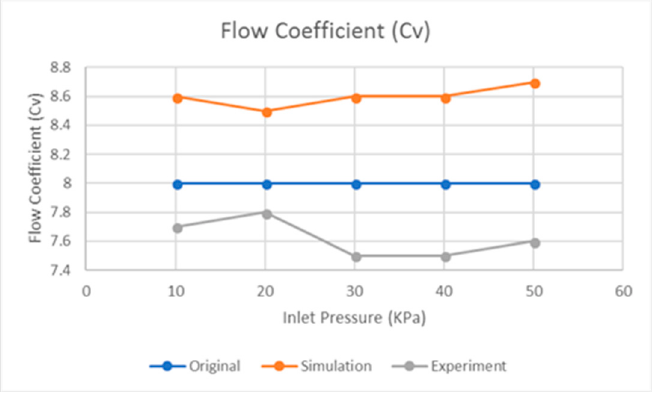
Figure 10. Flow coefficient comparison with original design.